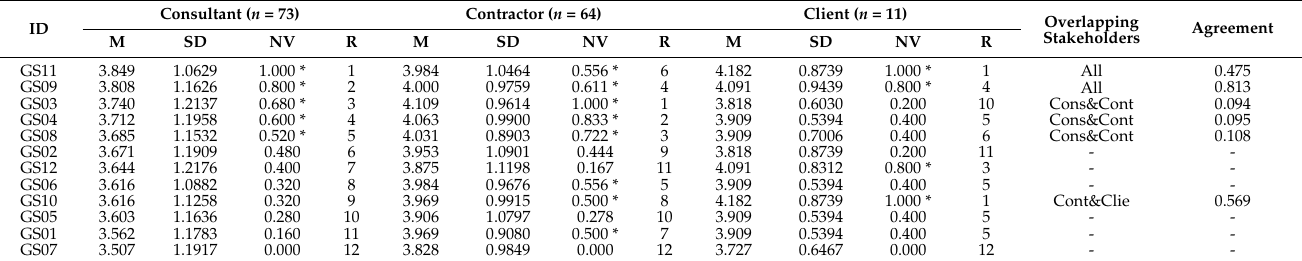
Table 3. Ranking of government strategies to enhance BIM implementation.